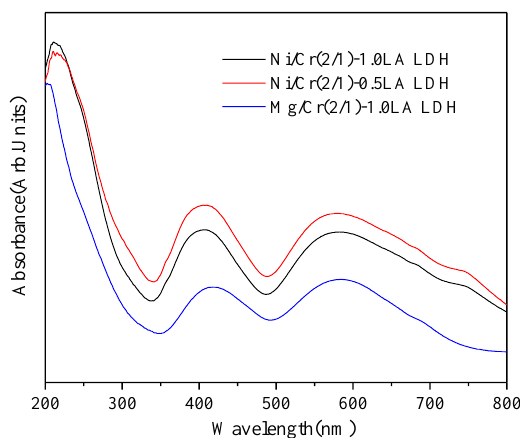
Figure 3. Diffuse reflectance UV−vis spectra of Ni/Cr(2/1)−xLA LDH(x = 1.0, 0.5) and Mg/Cr(2/1)−1.0LA LDH.